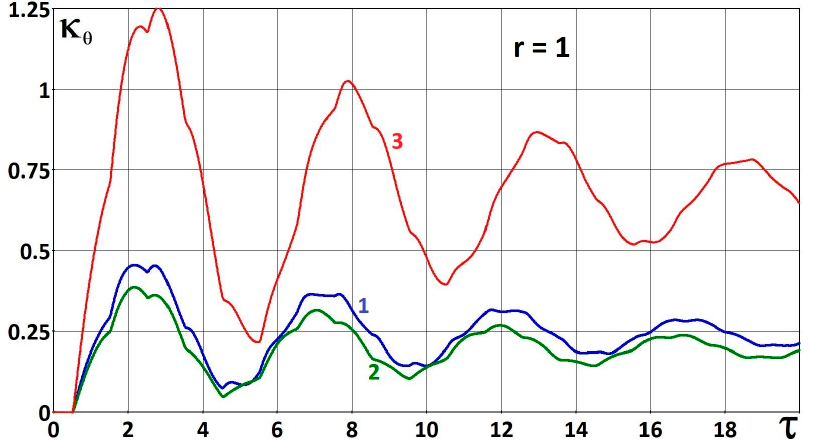
Figure 11. Time history of the relative circumferential stress at r = 1. Viscoelastic materials. FGM cylinder—curve 1; two-layer cylinder—curve 2; homogeneous cylinder—curve 3.